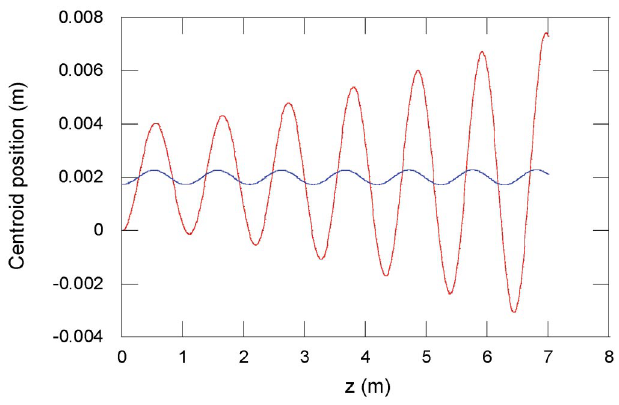
centroid.FIG. 9. (Color) Ion-hose calculation in the IFR using method 1. The red line shows the electron slice centroid and the blue line shows the ion